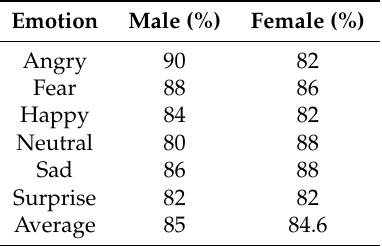
Table 2. Accuracy of male and female group using